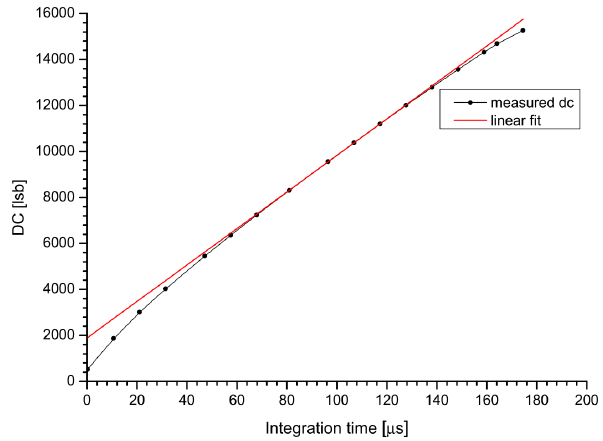
Figure 3. Nonlinearity curve for a single pixel from laboratory mea- surements as a function of integration time. The red curve represents a virtual detector with linear properties.